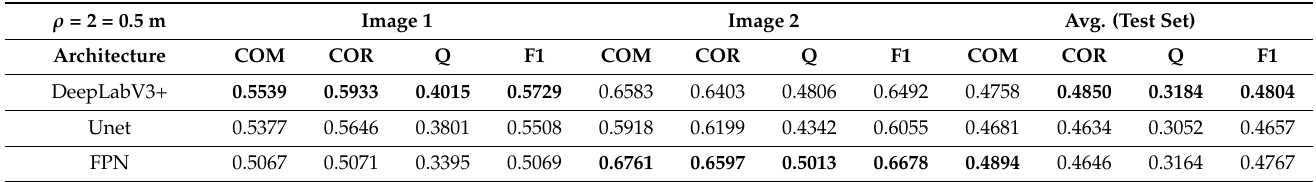
Table 2. Rural road extraction quantitative results for a ρ = 2 (using the Zhang–Suen thinning algorithm)—values in bold represent the road detection algorithm with the best performance in each parameter.